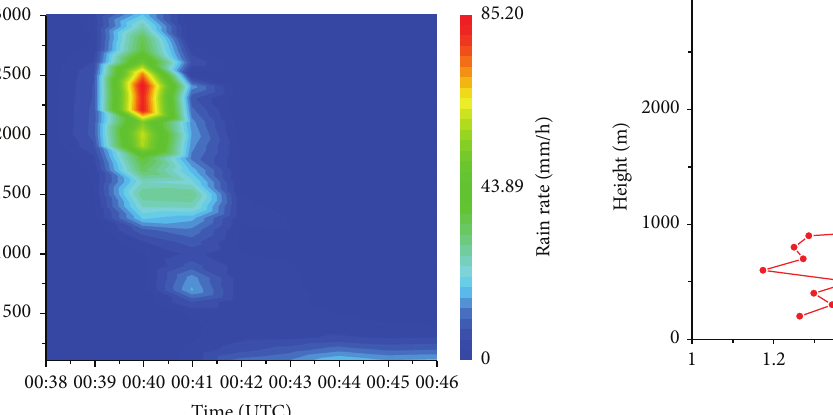
Figure 10: Parameter 𝜆 of the drop size distribution at the different heights